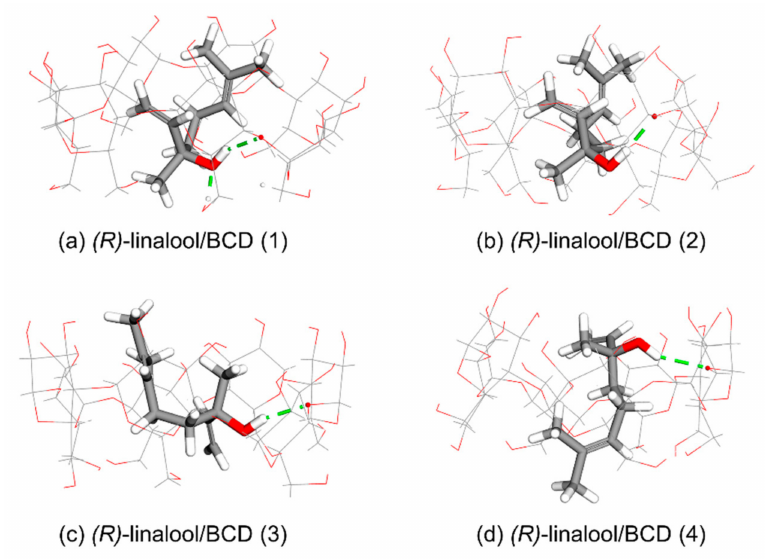
Figure 3. Energy-minimized structure of the 1:1 ( R )-linalool/BCD complexes from four clusters using PM7 method. BCD is presented as a line model. The linalool molecule is presented as a stick model. The green dashed line refers to hydrogen bond.